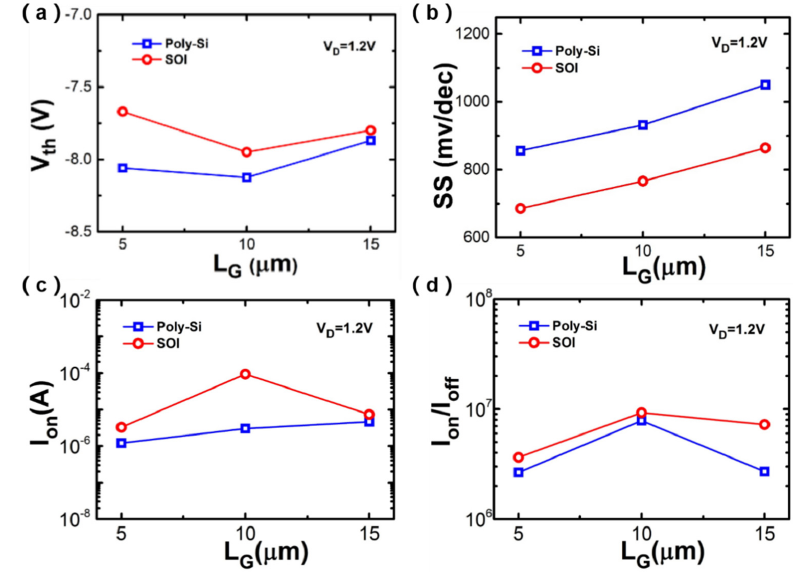
Figure 7. Comparison between low-temperature poly-silicon devices and SOI Si NW devices. ( a ) SS, ( b ) V th , ( c ) I on and ( d ) I on /I off ratio. Nanomaterials 2020 , 10 , x FOR PEER REVIEW